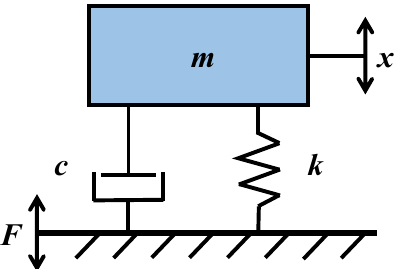
Figure 3. Simplified model of the resonant beam.